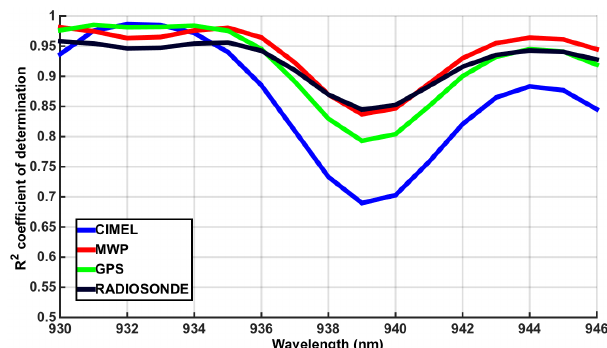
Figure 7. IWV retrievals from PSR using a spectral approach with different spectral windows, a fixed upper boundary at 946nm and a moving lower boundary on the x axis, compared to synchronous ones of CIMEL, GPS, MWP and radiosonde for the full 2-year mea- suring